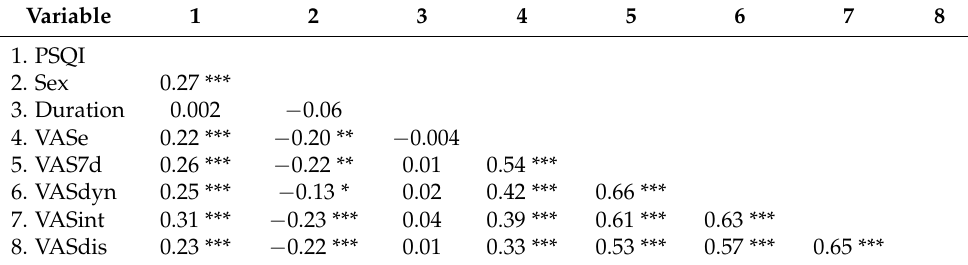
Table 3. Bivariate correlations among the variables included in the structural equation